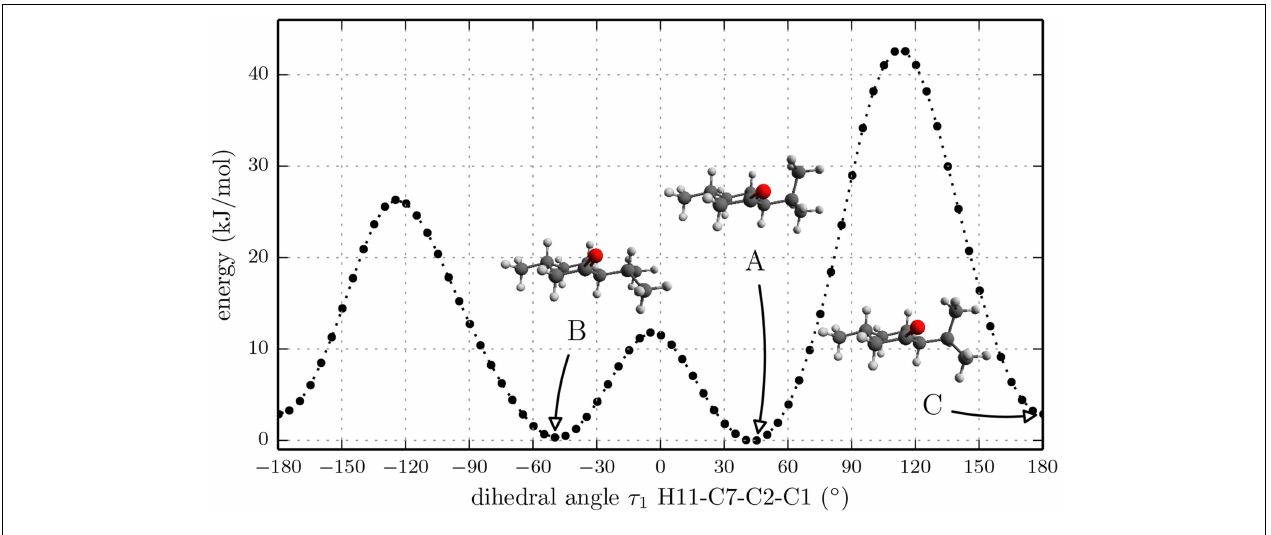
for (-)-menthone. The position of each minimum conformation (A, B, C) is indicated in the plot and illustrated with the corresponding structure.